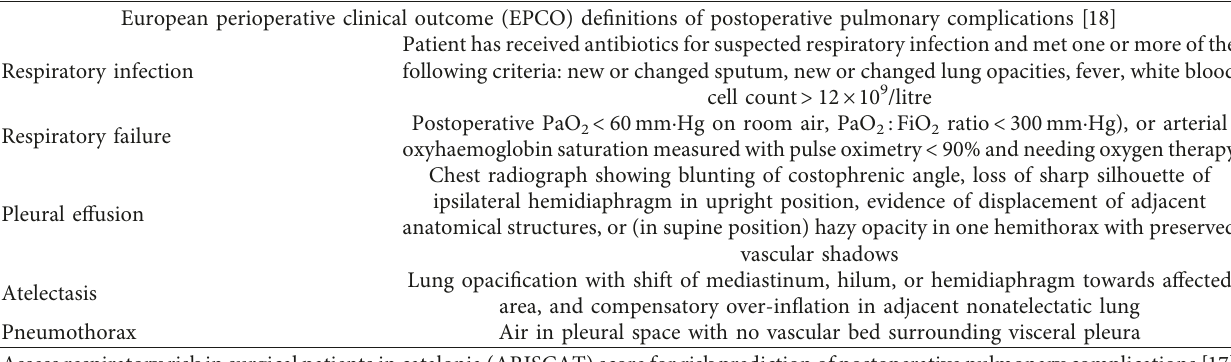
Table 1: Definitions used for outcome measurements and risk